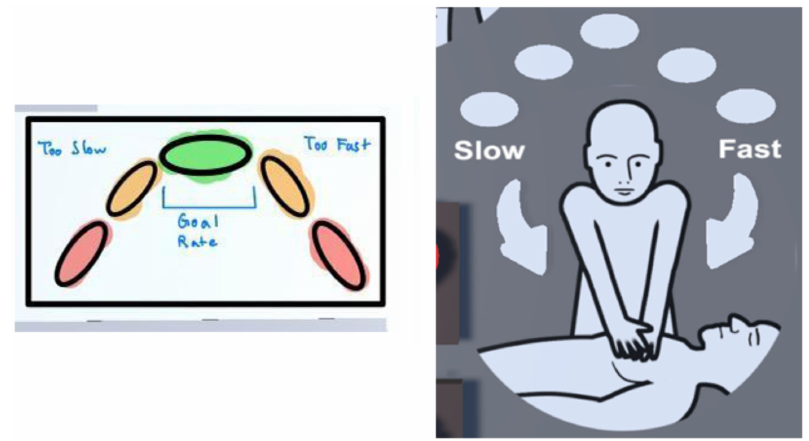
Figure 6. Early mockup and finalized version of the CPR rate